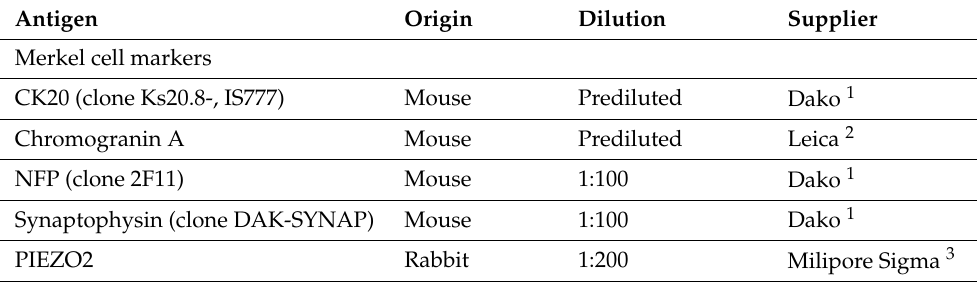
Table 1. Primary antibodies used in the study.